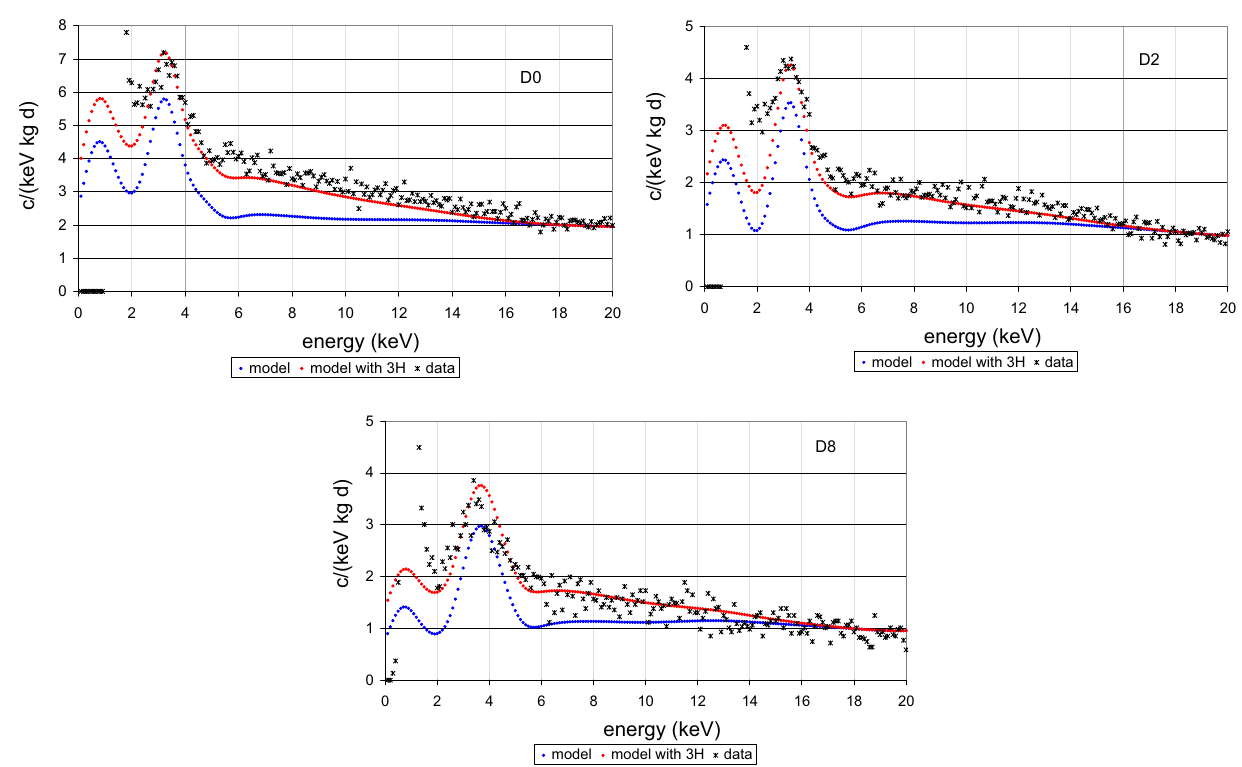
Fig. 6 The very low energy region of the energy spectra measured for D0 (top, left), D2 (top, right) and D8 (bottom) ANAIS detectors compared with the corresponding simulated models [42] including all the quantified intrinsic and cosmogenic activities in the detectors and main components of the set-up (blue) and adding also tritium in the